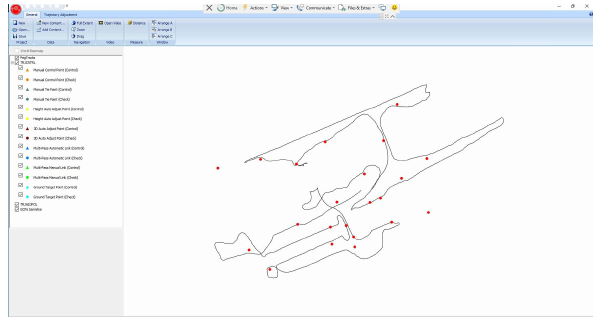
Figure 30. Import and visualization of GCPs, Sânmihaiu Român Lock.